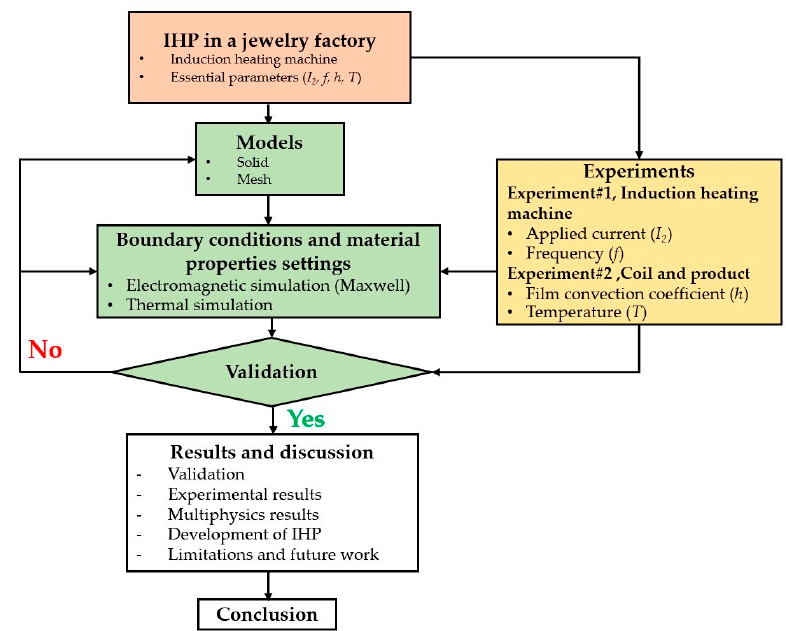
Figure 4. A flowchart of methodology.